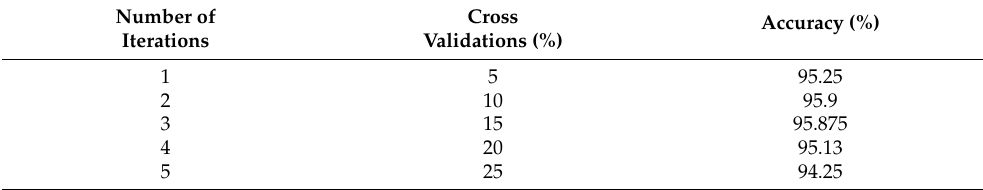
Table 8. Results of RF classifiers with maximum depth and cross-validation factor.